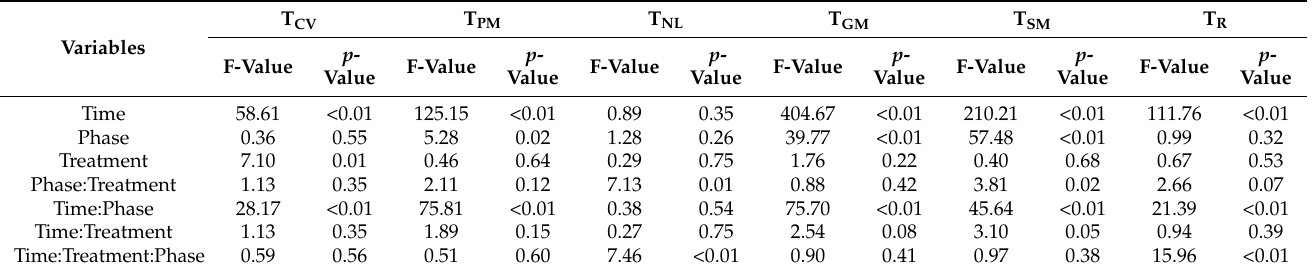
Table A3. Results of Analysis of Variance (ANOVA) for measured body temperature post-exercise.